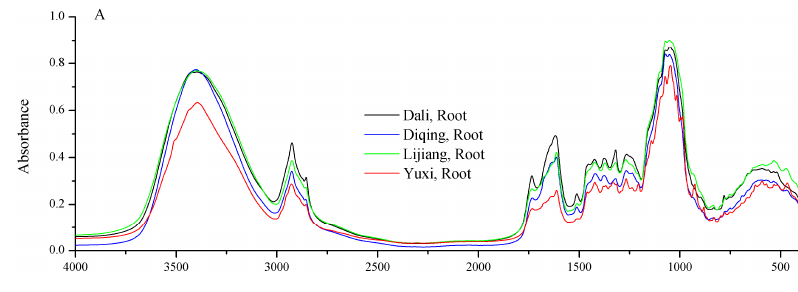
Figure 1. Contents of gentiopicroside in G. rigescens (mg/g) with different parts of plants from different geographical origins by